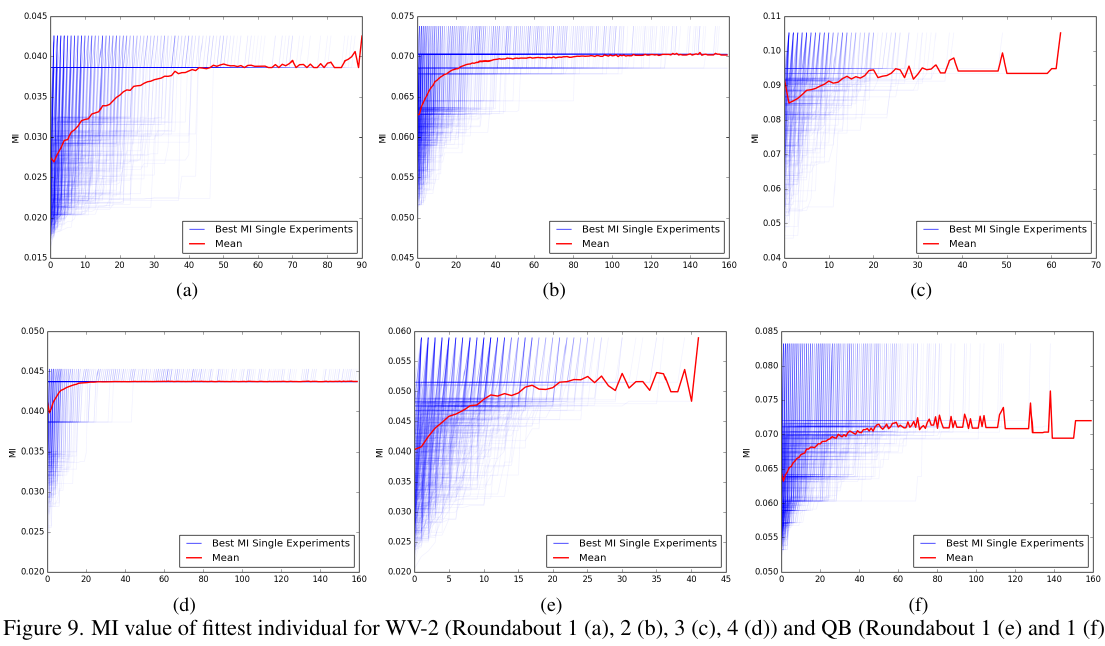
Figure 9. MI value of fittest individual for WV-2 (Roundabout 1 (a), 2 (b), 3 (c), 4 (d)) and QB (Roundabout 1 (e) and 1 (f))